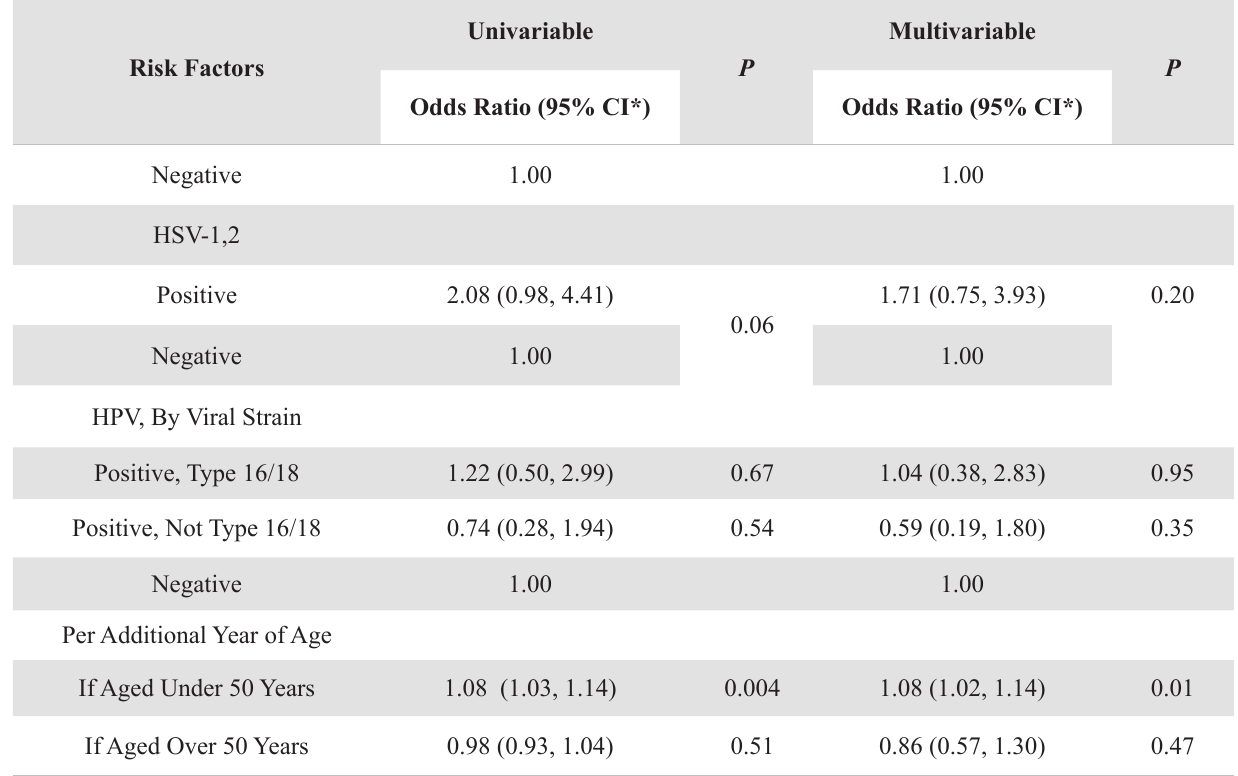
CI, confidence Table 3 . Multivariable Models of Count and Volume of Uterine Leiomyoma,